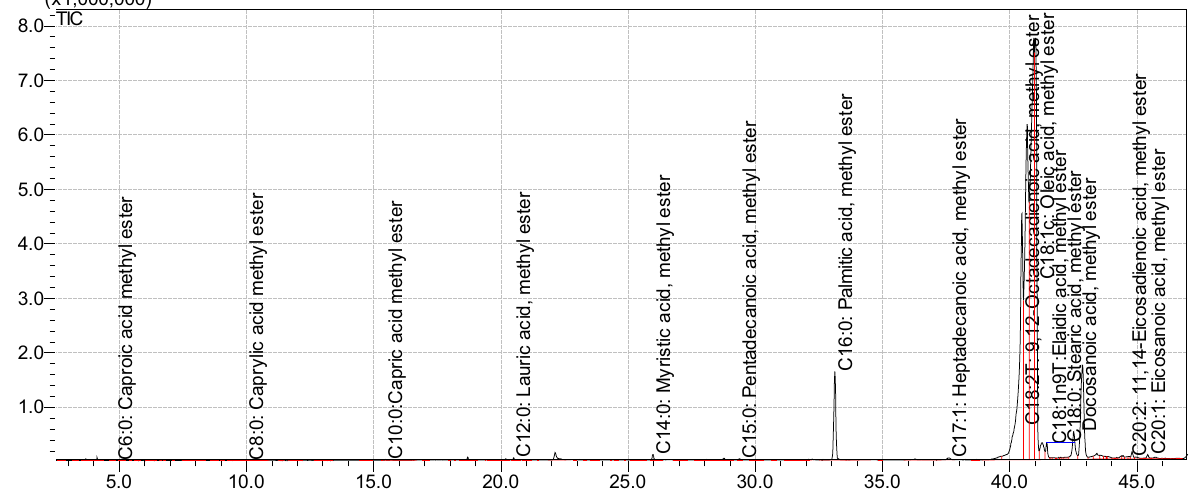
Figure 2: GC - MS analysis of oil extracted from CO fraction of F. benghalensis .